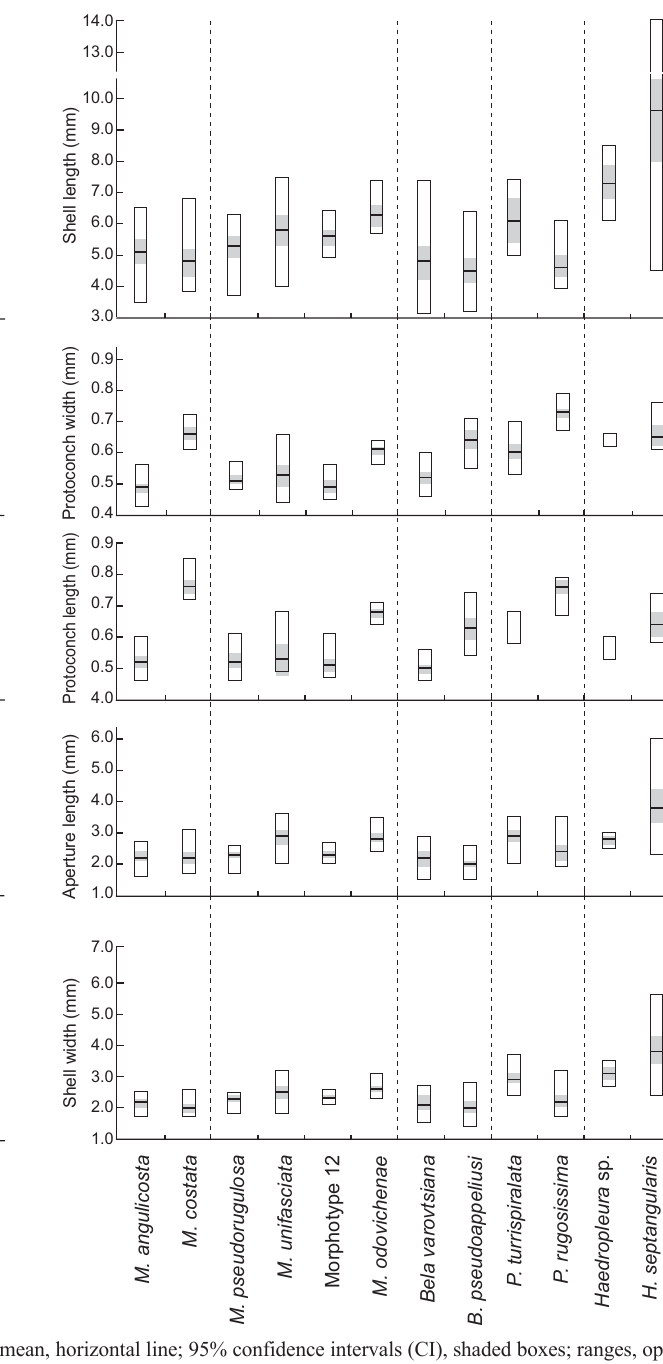
boxes (specimen measurements in SOM 2). The mean sample is a point estimate of the population mean ( μ ), and the corresponding CI is a range of plausi-